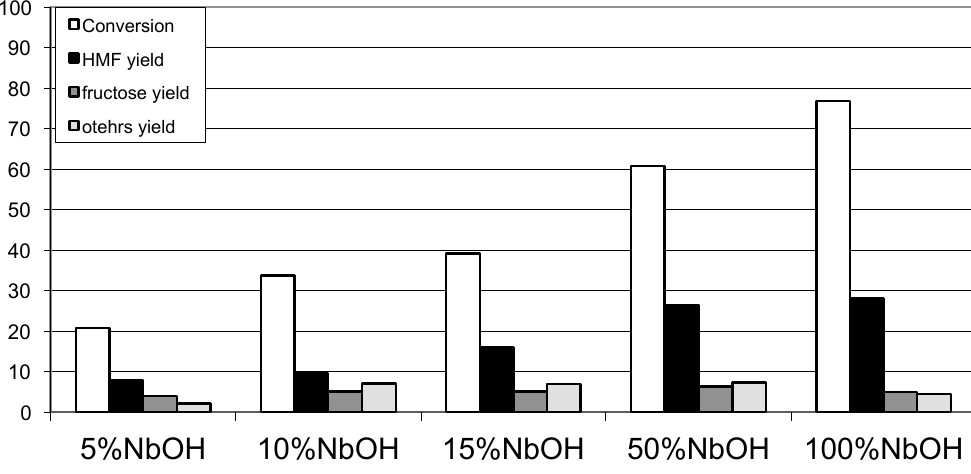
Figure 9. Glucose conversion in water in the presence of increasing amounts of